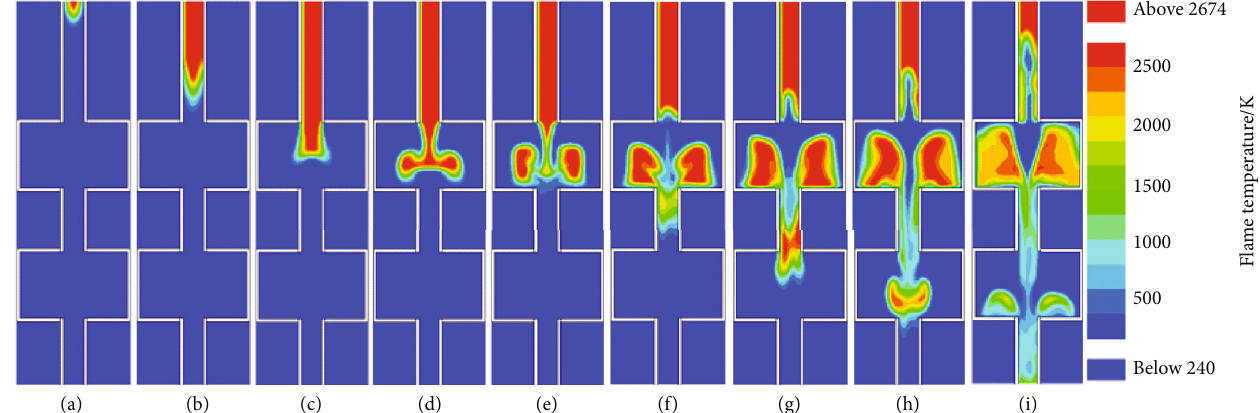
Figure 8: The propagation process of gas explosion fl ame in the dual